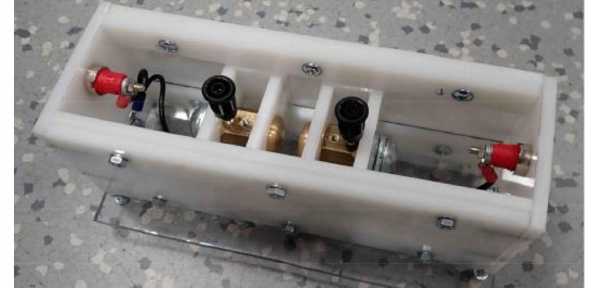
Figure 9. Adjustable sphere–sphere spark gap